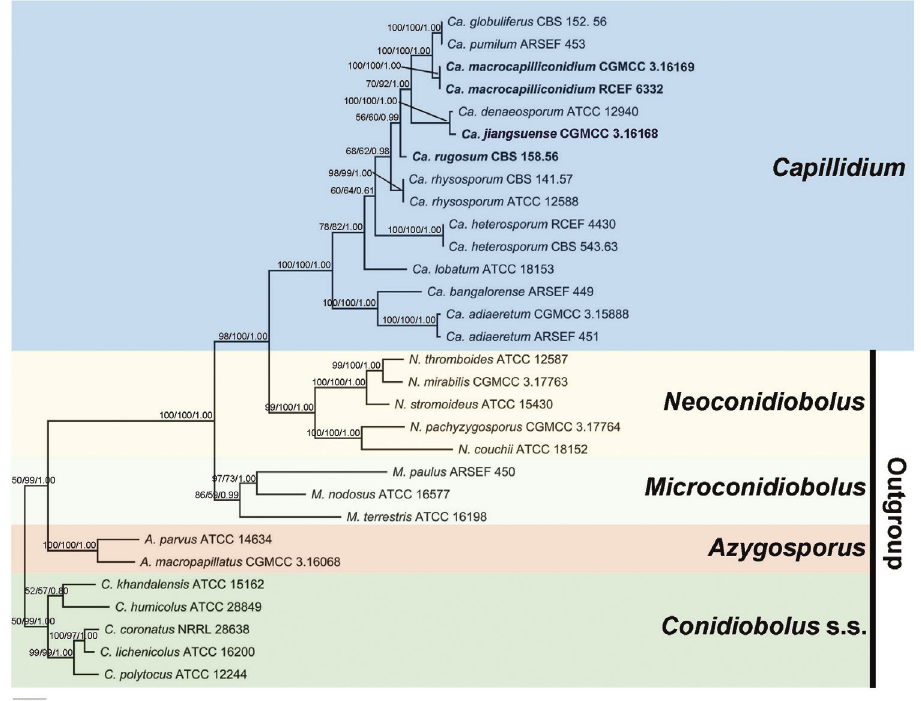
Figure 1. The phylogenetic tree of Capillidium constructed using Maximum Likelihood analyses on nucLSU, EFL and mtSSU sequences. Conidiobolus s.l. species were used as outgroups. New taxa are in- dicated by bold text. Maximum Parsimony bootstrap values (≥ 50%) / Maximum Likelihood bootstrap values (≥ 50%) / Bayesian posterior probabilities (≥ 0.50) of clades are provided alongside the branches. The scale bar at the lower left indicates substitutions per